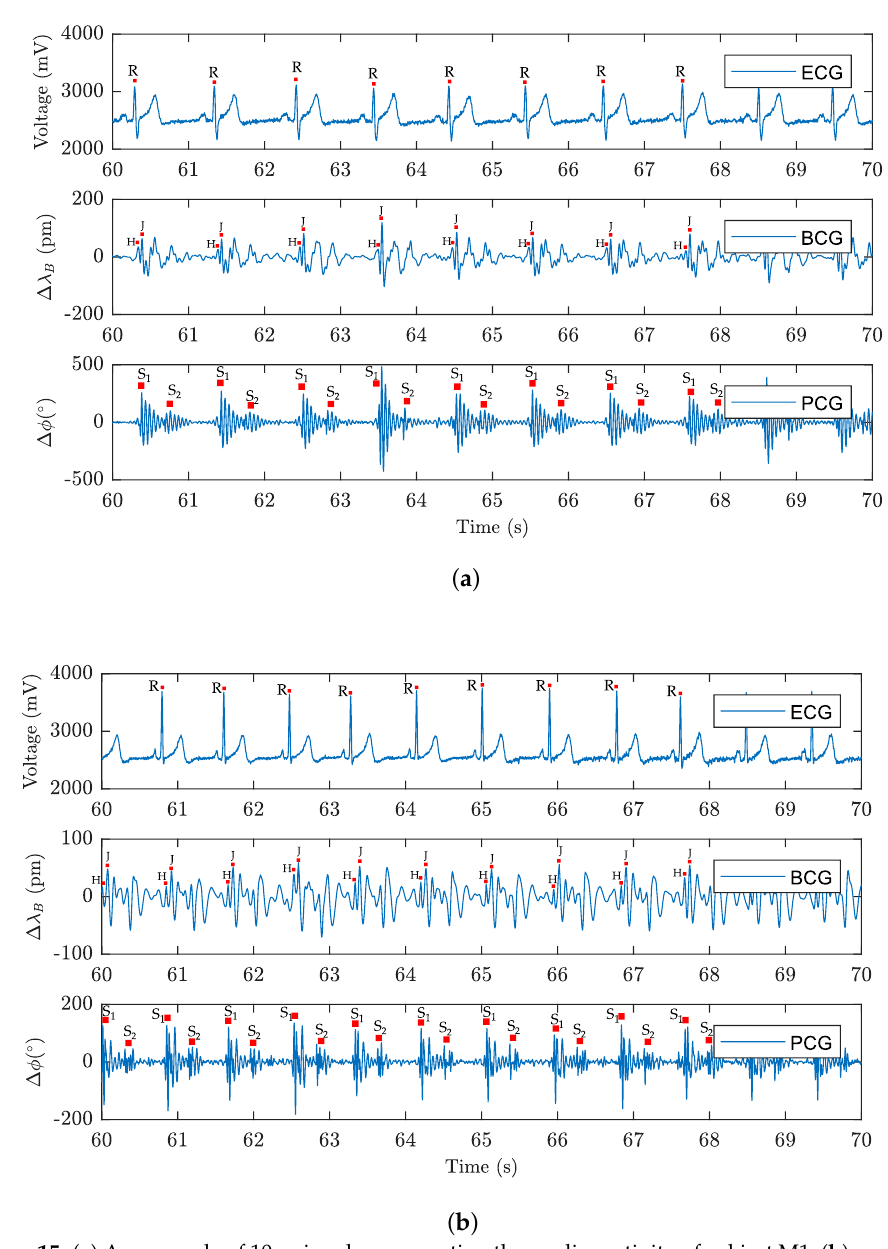
Figure 15. ( a ) An example of 10-s signals representing the cardiac activity of subject M1; ( b ) an example of 10-s signals representing the cardiac activity of subject